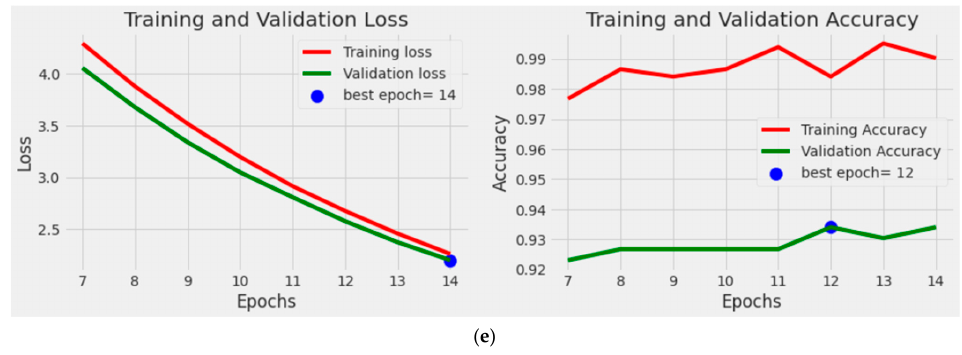
Figure 5. Training and validation accuracy and loss for our DNN method: ( a ) EfficientNetB3; ( b ) ResNet50; ( c ) MobileNetV2; ( d ) VGG16; ( e ) VGG19.